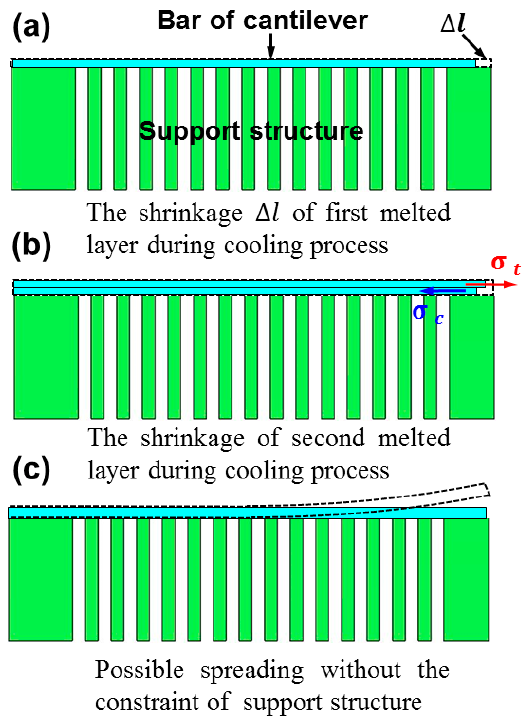
Figure 9. Schematic description of shrinkage of the ( a ) first and ( b ) second melted layer during the cooling process of the bar in the cantilever structure; ( c ) constraint of the support structure during deformation.